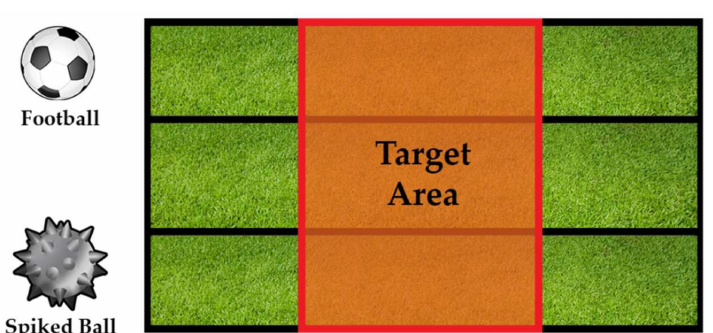
Figure 3. Whack-a-Mole Game.